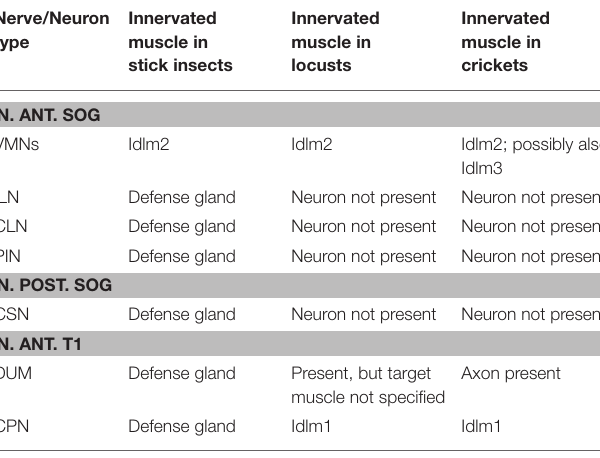
TABLE 2 | Summary of identified motoneurons and their muscle targets in the defense gland